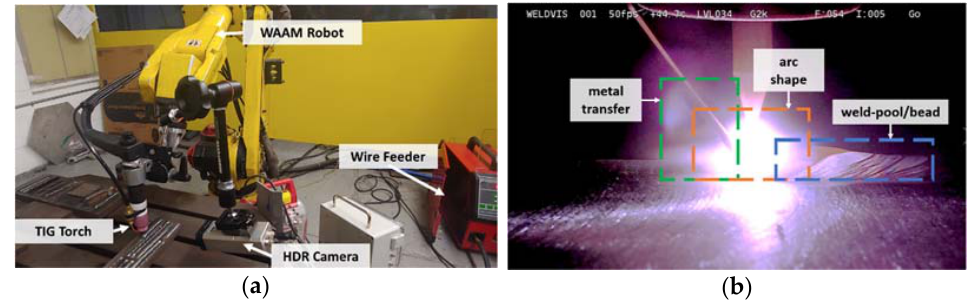
Figure 2. ( a ) Experimental setup; ( b ) welding area monitored by HDR camera.